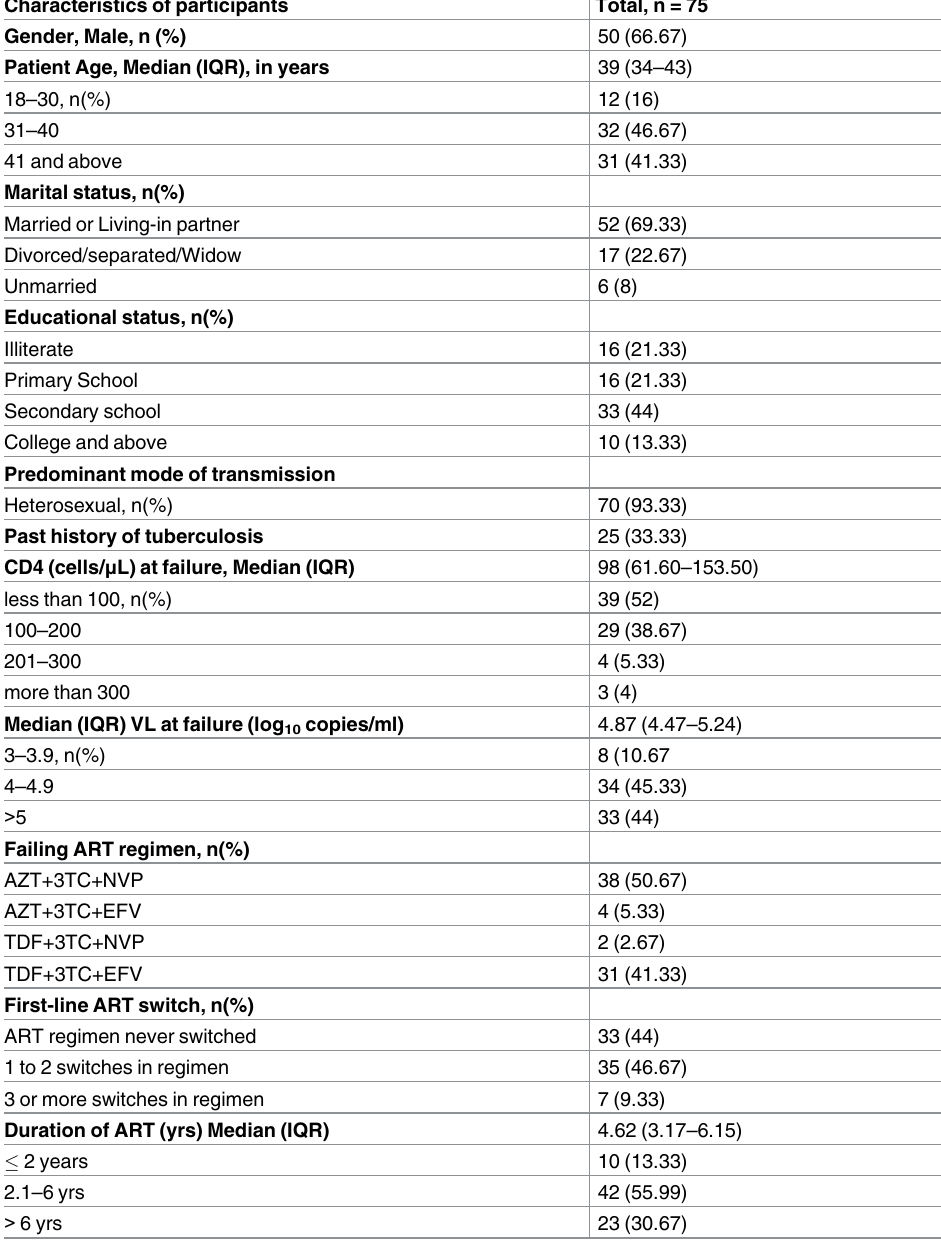
Table 1. Demographic details of the 75 study participants with failure of first-line